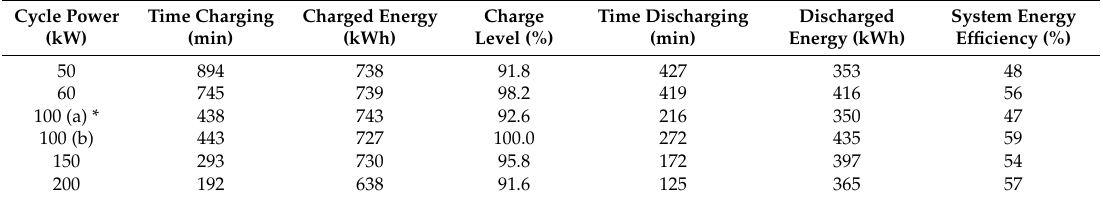
Table 1. Charge and discharge energies and system energy efficiencies at different charge/discharge powers.